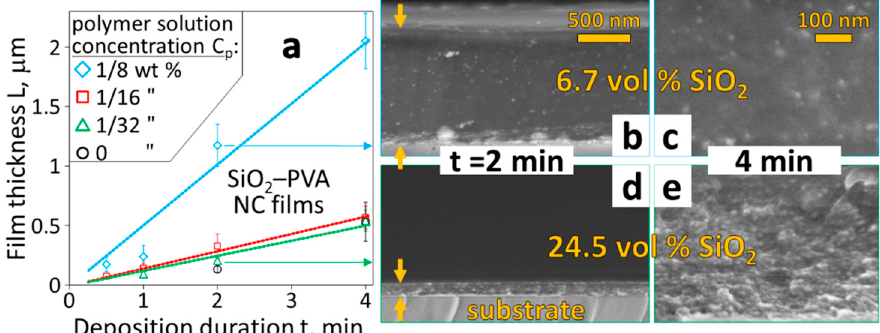
Figure 2. ( a ) The SiO 2 nanocomposite (NC) film thickness L as a function of deposition duration t for varying PVA concentrations C p in polymer solutions (diamonds, squares, triangles, circles for C p = 1/8, 1/16, 1/32 and 0 wt %, respectively). ( b – e ) SEM cross-section images of these films deposited on glass for t = 2 ( b , d ) and 4 min ( c , e ) with C p = 1/8 ( b , c ) and 1/32 wt % ( d , e ). Smooth surface and homogeneous SiO 2 nanoparticle distribution (bright dots in images) within the PVA (dark grey surrounding matrix) are seen in these void-free films. Scale bars in ( d , e ) same as in ( b , c ), respectively.